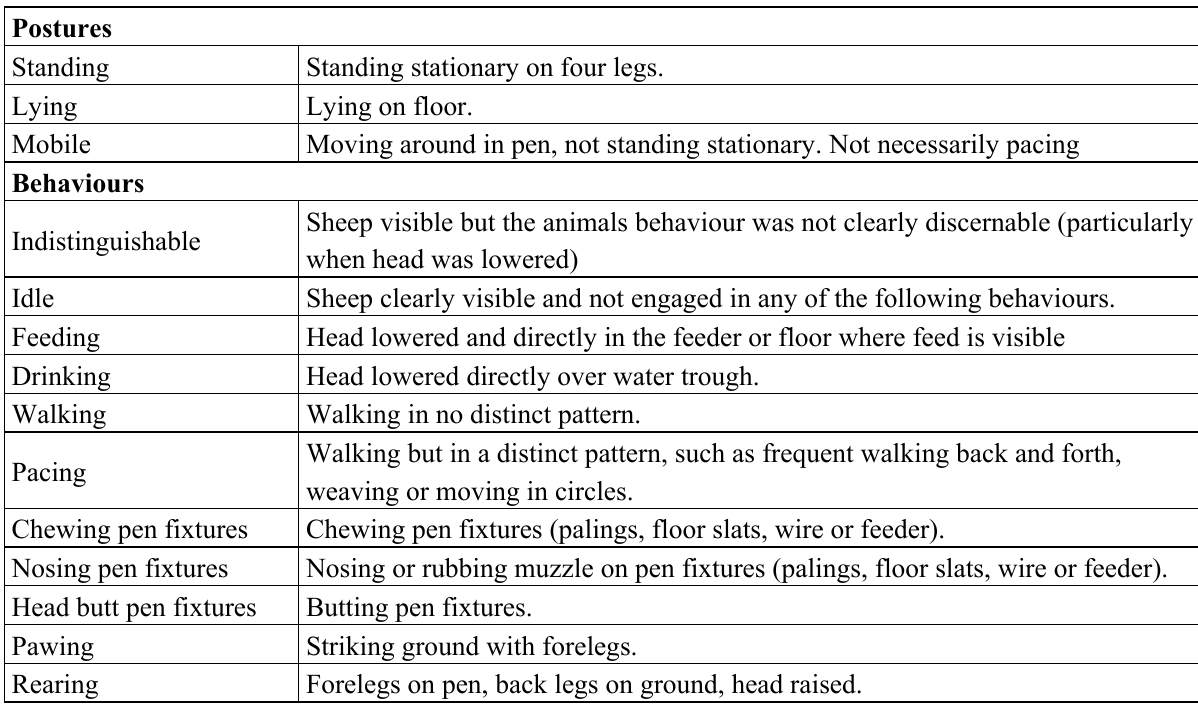
Table 1. Ethogram used in constructing time